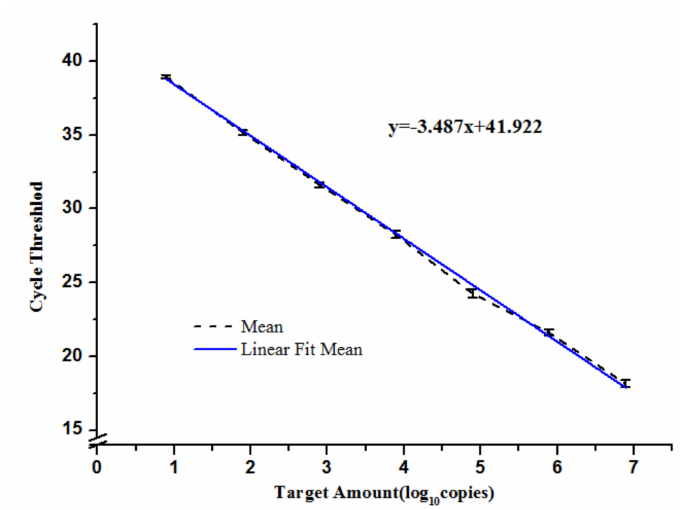
Figure 2. Development of probe-based qPCR: Relationship between known gene copies (GC) number of the standard plasmid DNA and CT values. Average of three reactions is shown and error bars indicate standard